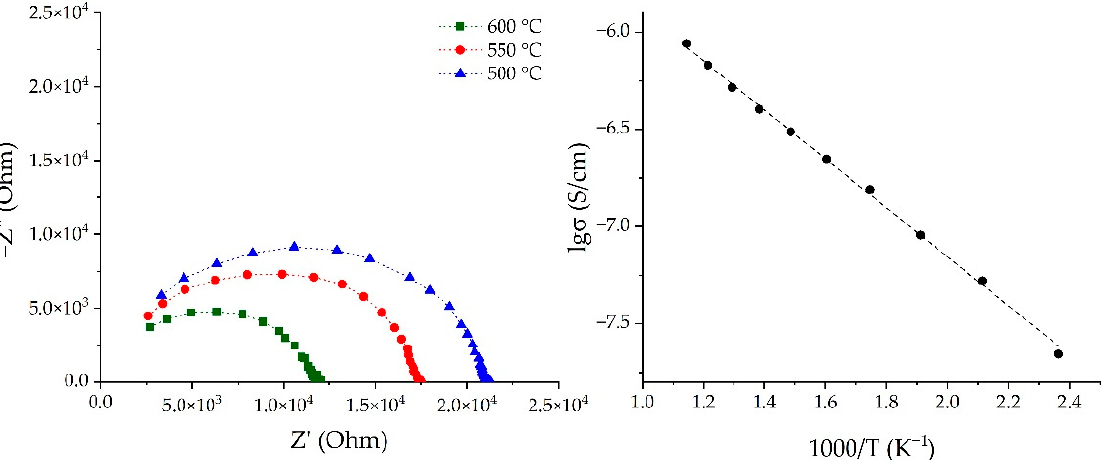
Figure 7. Frequency dependences of the impedance of the (NiO-SDC)/SDC/(LSCF-SDC) three-layer structure ( left ) and the temperature dependence of its specific conductivity ( right ).